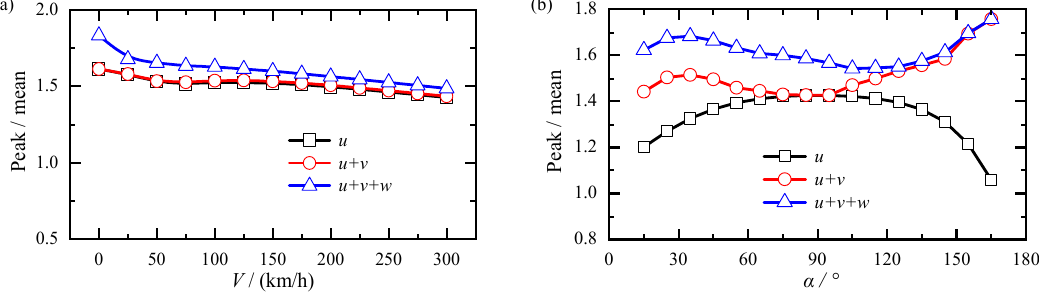
Figure 22. Side force peak value/mean ratio at different turbulence combinations: ( a ) train speed effect ( U = 20 m/s, α = 90°); ( b ) crosswind angle effect ( U = 20 m/s, V = 300 km/h).